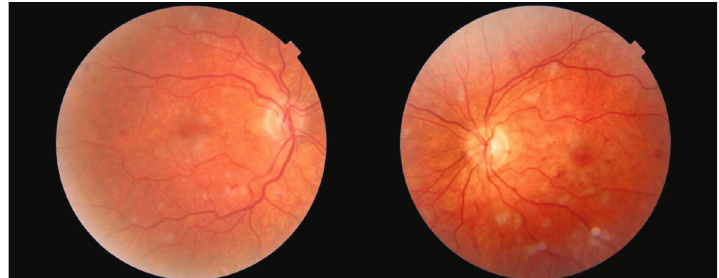
Figure 1: Fundal photos of the right and left eyes on presentation demonstrating intraretinal haemorrhages, cotton wool spots and Purtscher fl ecken with the characteristic clear zone between the lesions and the blood vessels.